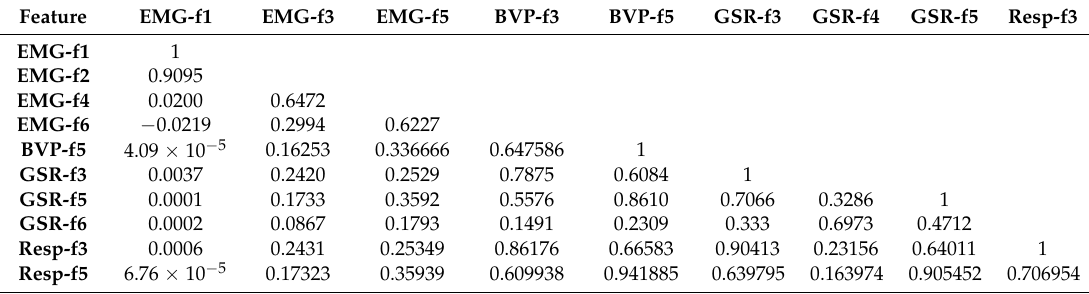
Table 10. Correlation-based ranking for physiological dataset.